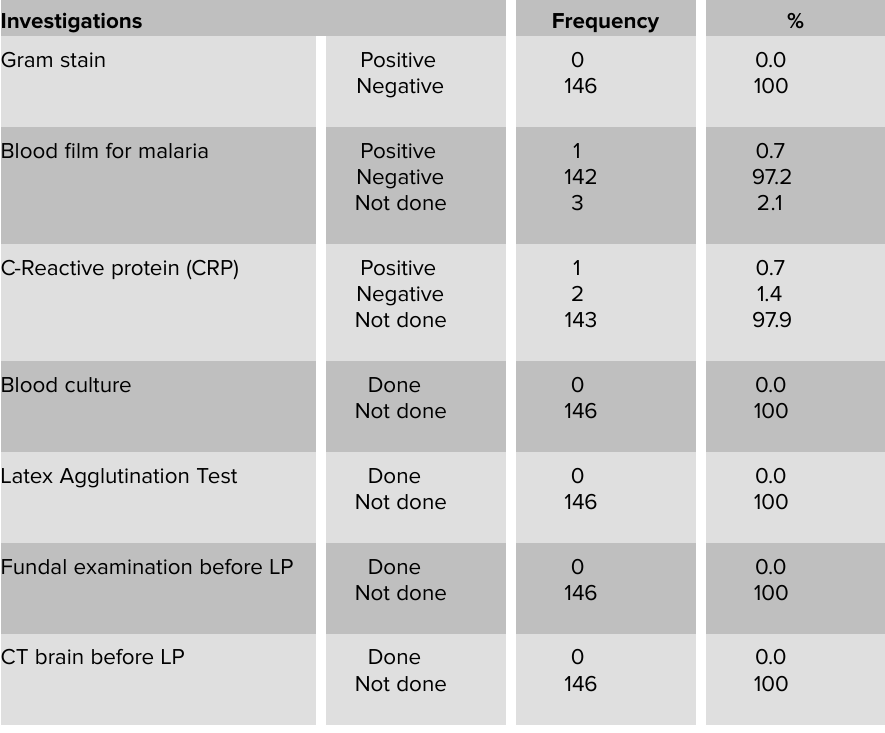
Table 5: Distribution of the study population according to investigation characteristics (n =146).